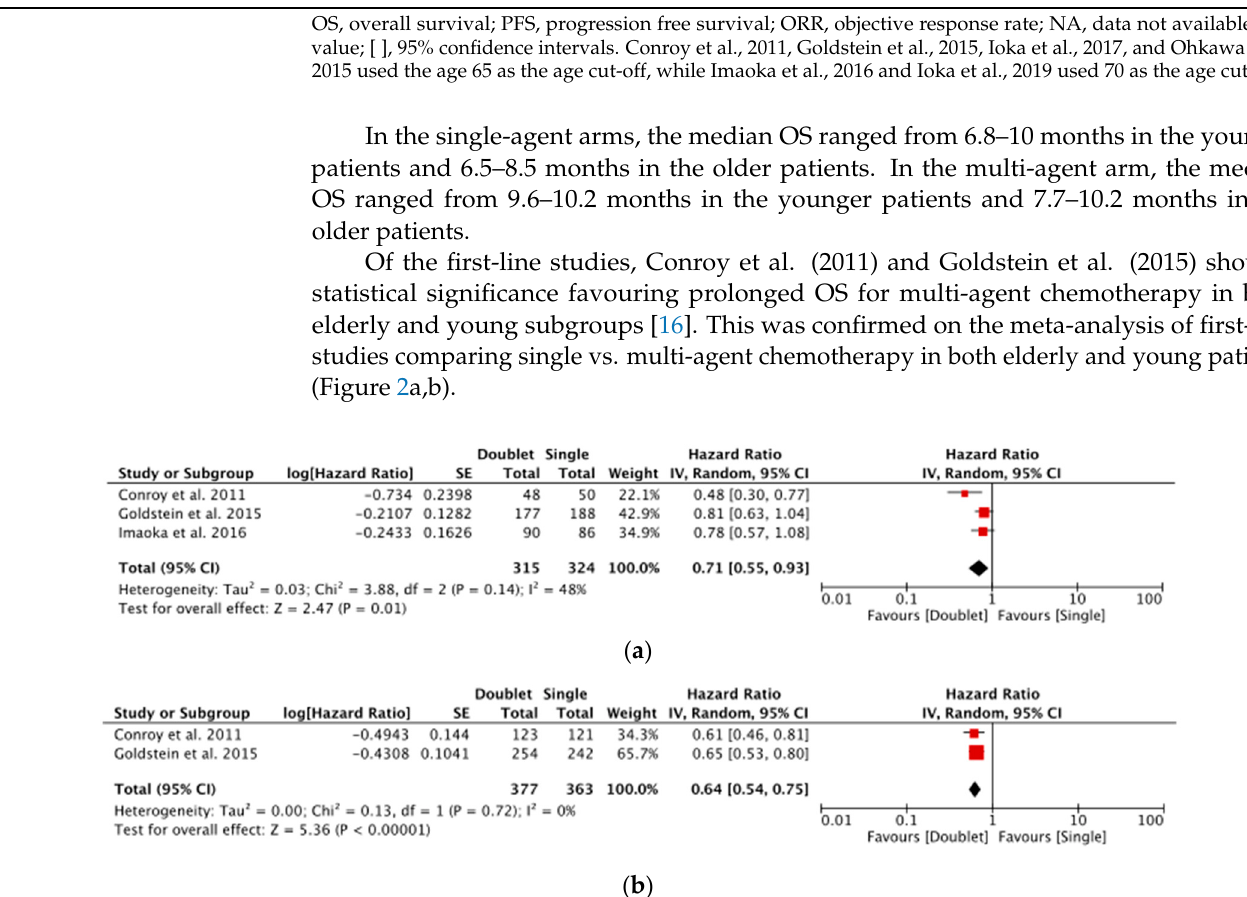
Figure 2. ( a ) Forest plot showing meta-analysis of overall survival in elderly patients for first-line studies [15–17] and ( b ) Forest plot showing meta-analysis of overall survival in young patients for first-line studies [15,16].